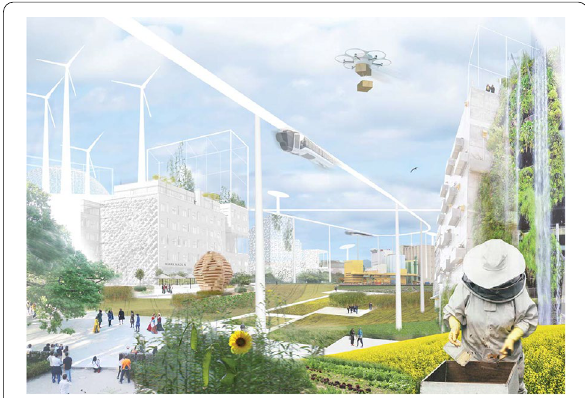
Fig. 3 Plusstaden,